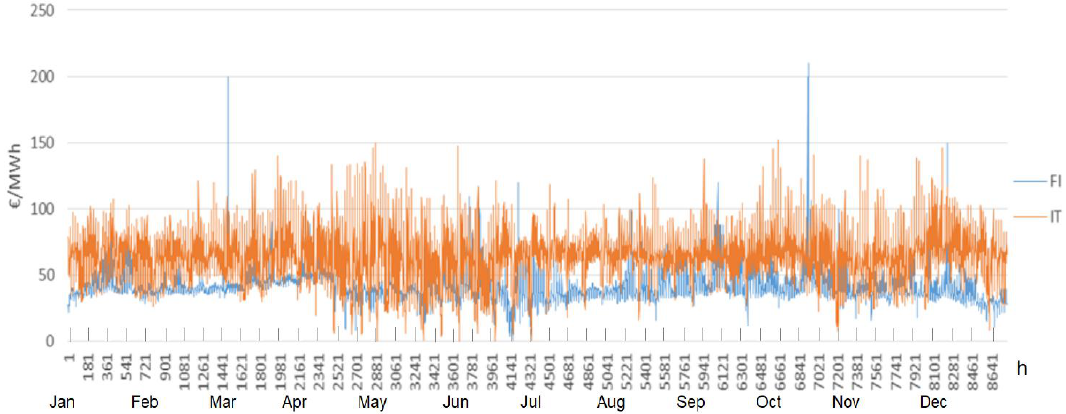
Figure 29. Electricity market price trend for Finland and Italy in 2013.